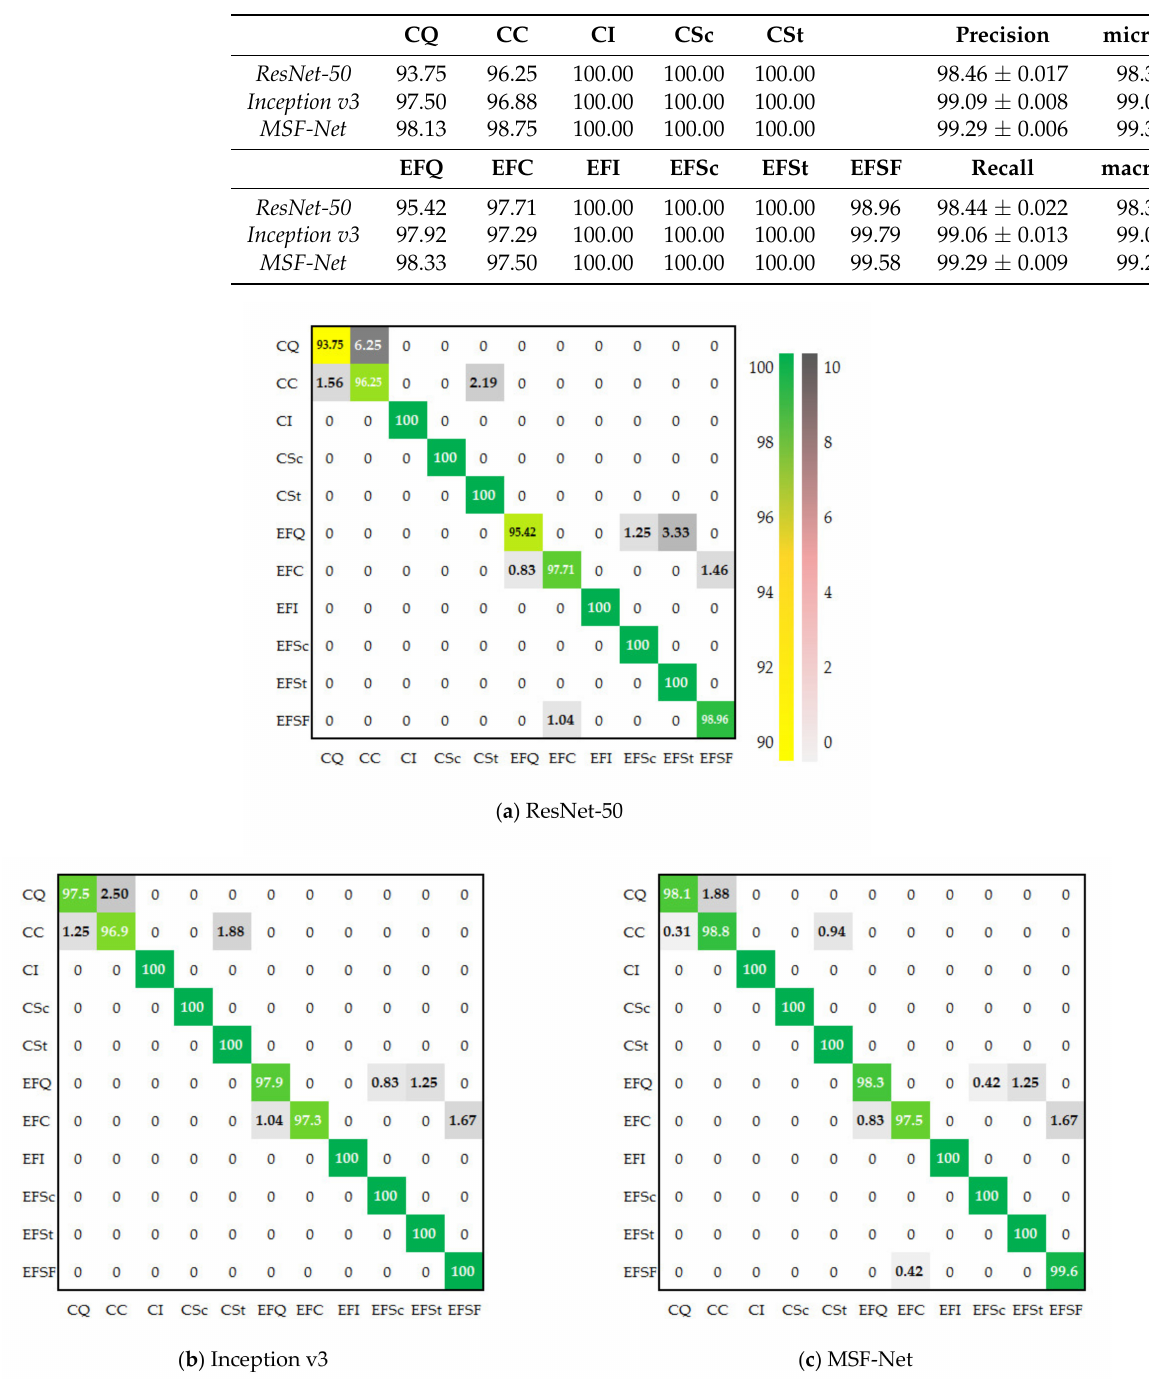
Figure 14. Confusion matrix of three CNNs on the surface defect data set of roller (unit: